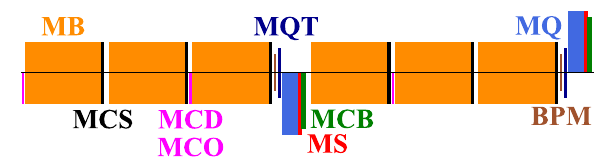
FIG. 2. Schematic plot of a LHC FODO cell, consisting of six main dipoles (MBs), each equipped with a sextupole spool piece corrector (MCS). An octupole (MCO) and a decapole (MCD) corrector are placed after every second MB. The short straight section is equipped with a main quadrupole (MQ), a trim quadrupole (MQT), an orbit corrector (MCB), a main sextupole (MS) and a beam position monitor (BPM). Focusing and defocusing quadrupoles, respectively, are shown below and above the horizontal